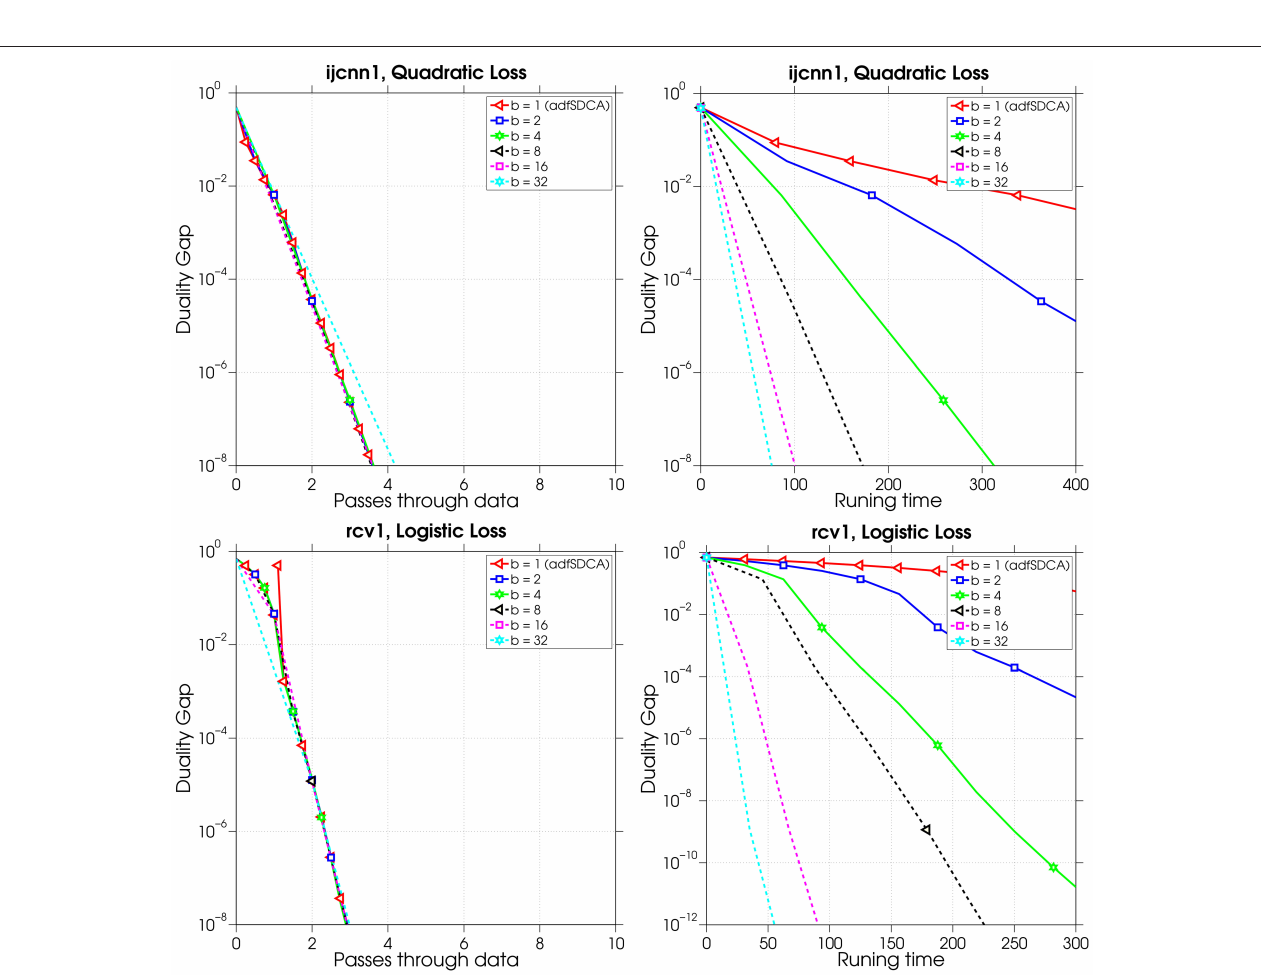
FIGURE 5 | Plots showing the performance of adfSDCA in terms of the number of passes through the data and running time, on different loss functions, as the batch size varies.